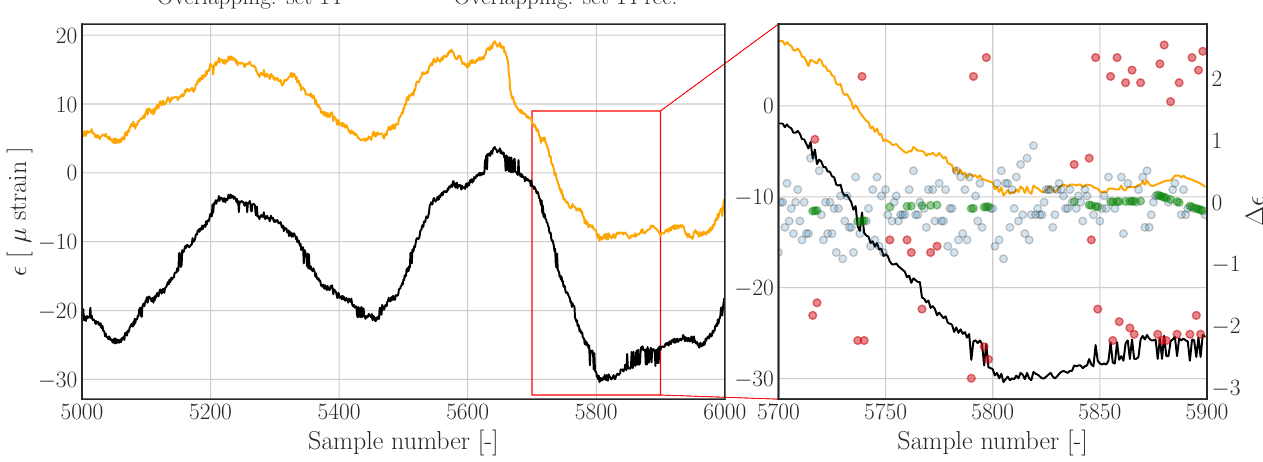
Figure 13. Left : Subset of data set 14 from Overlapping.hdf5 (dashed), and reconstructions (solid) using the Hampel filter based method . The segment wise threshold levels are processed using an additional median filter. Right : Zoom in on region containing jumps. Nominal difference samples are indicated with blue dots, outliers and corresponding outlier replacements are indicated by red and green dots,